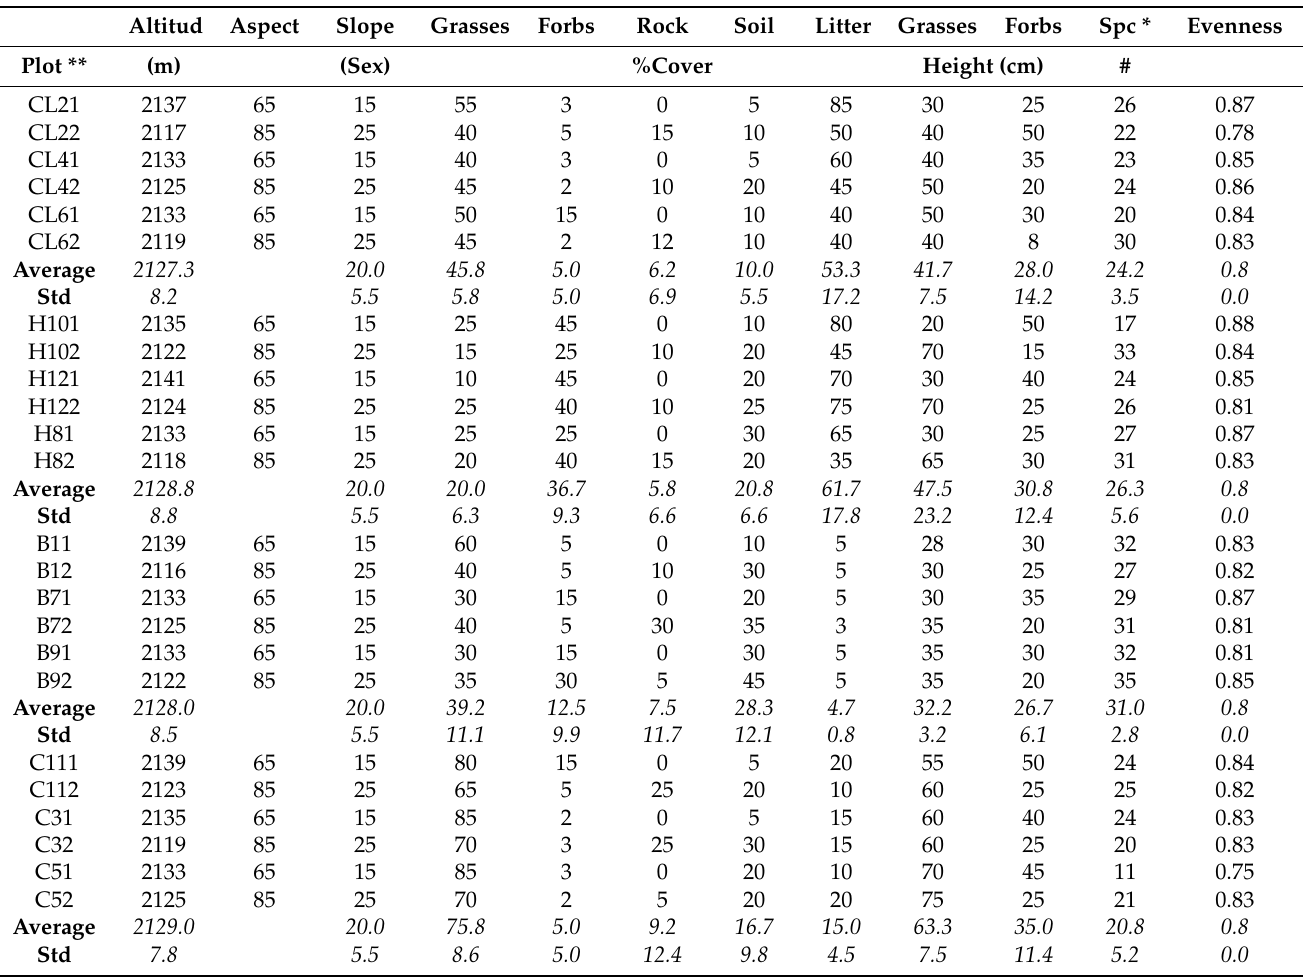
Table 1. General abiotic and plant community information of the plots (* Spc: Species richness; #: number). Average values and standard deviation (Std) for the information of the different variables are also